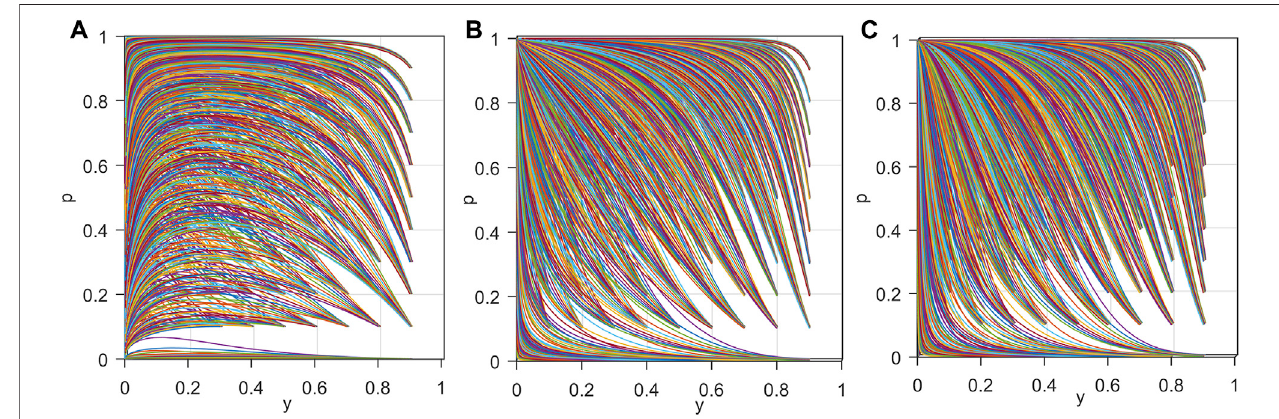
FIGURE 6 | The impact of reputation value premium and reputation loss. (A) when the situation is (0, 0). (B) when the situation is (4, 3). (C) when the situation is (8, 6).